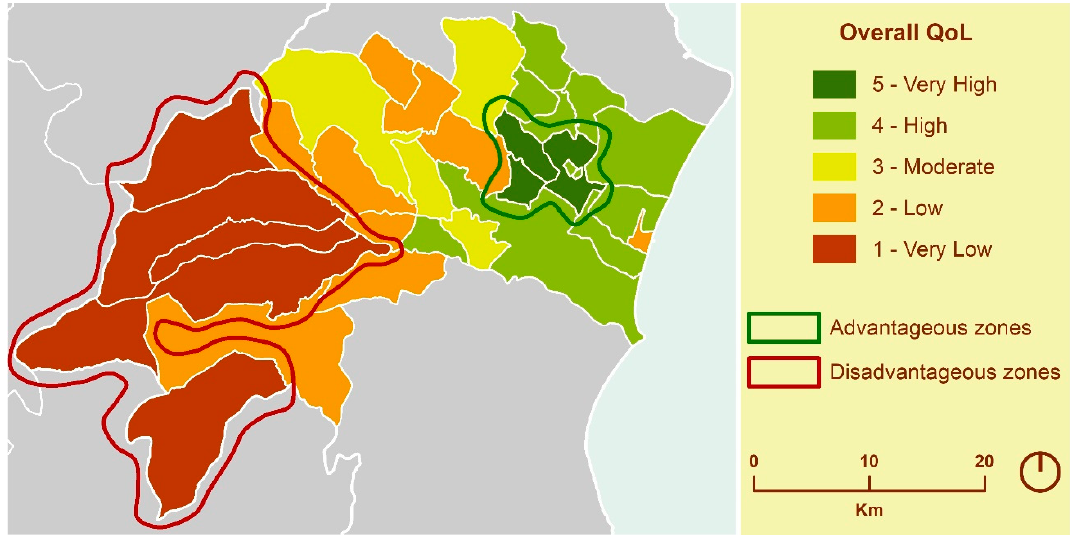
Figure 7. Overall QoL levels, LAUs of the Katerini Municipality.